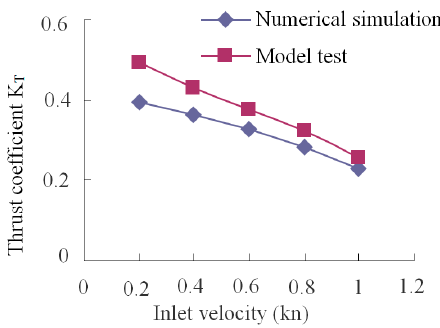
Figure 4. The mesh comparison results used in this paper.